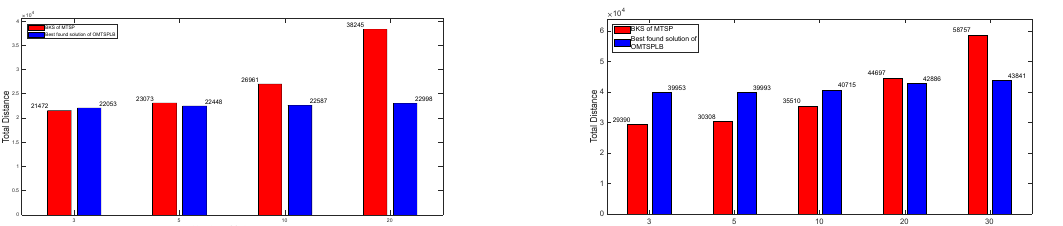
Fig 11. Comparison of minimum distance on mtsp-150 Fig 12. BKS of MTSP Vs. best found solution of OMTSPLB on mtsp-51